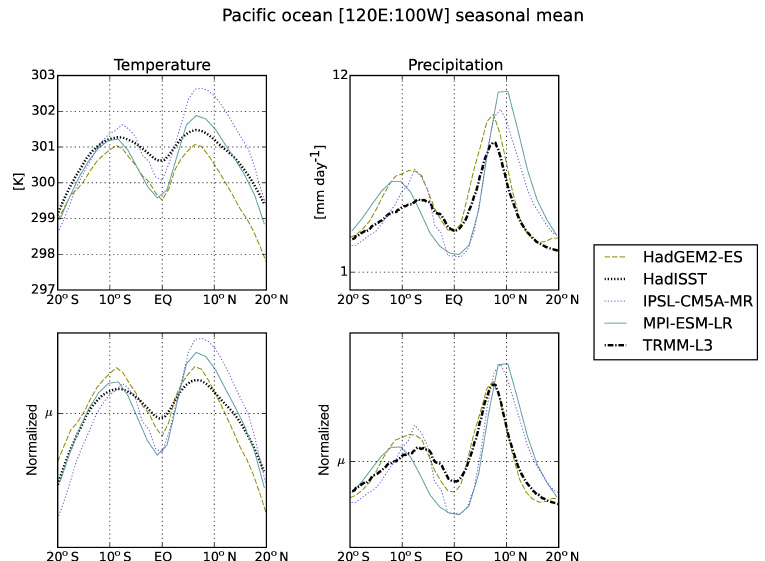
Figure 16. Latitude cross section of seasonal and zonally averaged values of SSTs and precipitation for the tropical Pacific (zonal averages are made between 120 ◦ E and 100 ◦ W). The upper panel shows absolute values of SST and precipitation, and the lower panel shows values normalized by their respective tropical mean value (20 ◦ N to 20 ◦ S). The figure shows that HadGEM2-ES simulates a double ITCZ in the equatorial Pacific, with excessive precipitation south of the Equator. This bias is accompanied by off-equatorial warm biases in normalized SST in both hemispheres and a relative cold bias along the Equator. The IPSL-CM5A-MR and MPI-ESM-LR models better capture the SST and precipitation distributions in the tropical Pacific. Produced with namelist_TropicalVariability.xml